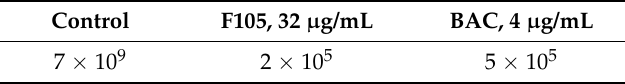
Table 2. CFUs number of S. aureus after 18 h treatment.